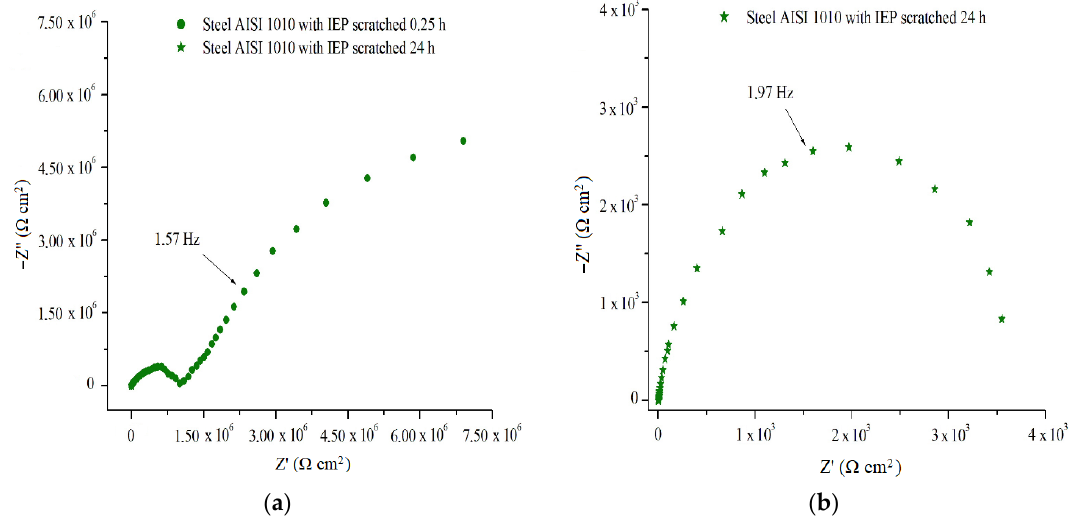
Figure 14. EIS in representation of Nyquist for scratched IEP coated AISI 1010 steel after ( a ) 0.25 h and 24 h; ( b ) 24h immersion in 2 mol L −1 H 2 SO 4